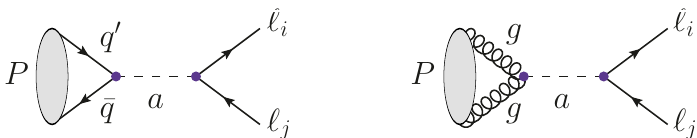
‘ i ‘ j and ‘ j ‘ i P via the ALP couplings ! !